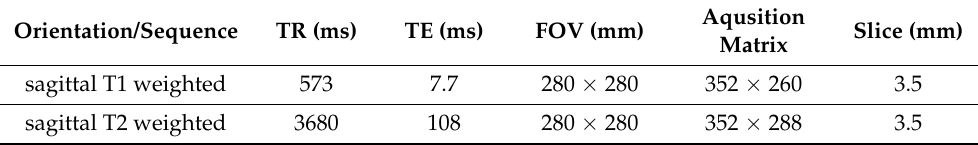
Table 1. MRI scan